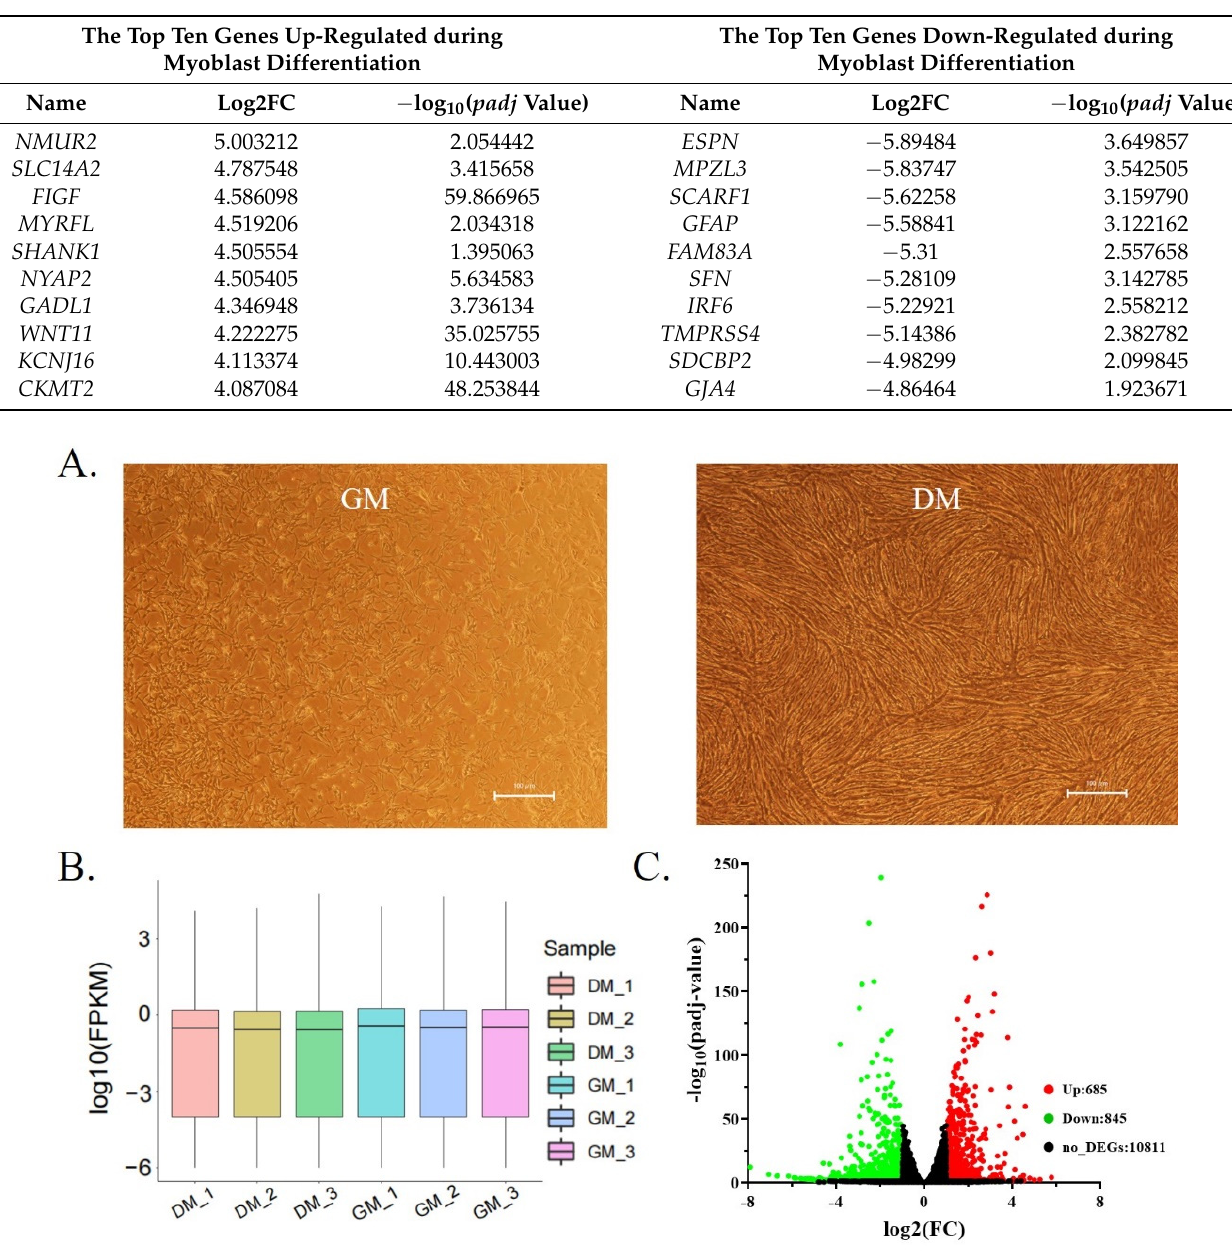
Figure 1. Shitou goose myoblasts isolation and transcriptome sequencing. ( A ) The state of proliferation and differentiation of Shitou goose myoblasts; ( B ) box diagram of transcriptome expression of each sample; ( C ) the volcano plot showing DEGs between GM and DM.